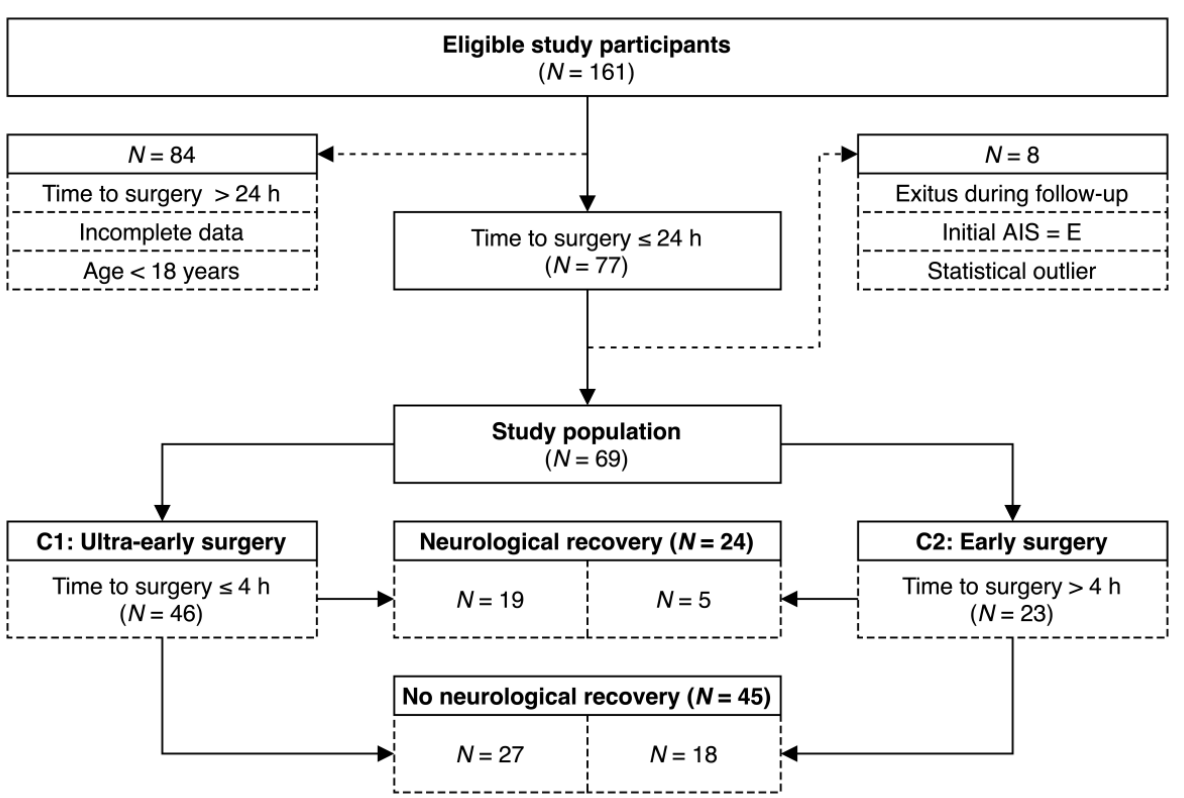
Figure 1. Flow diagram of the formation of the study